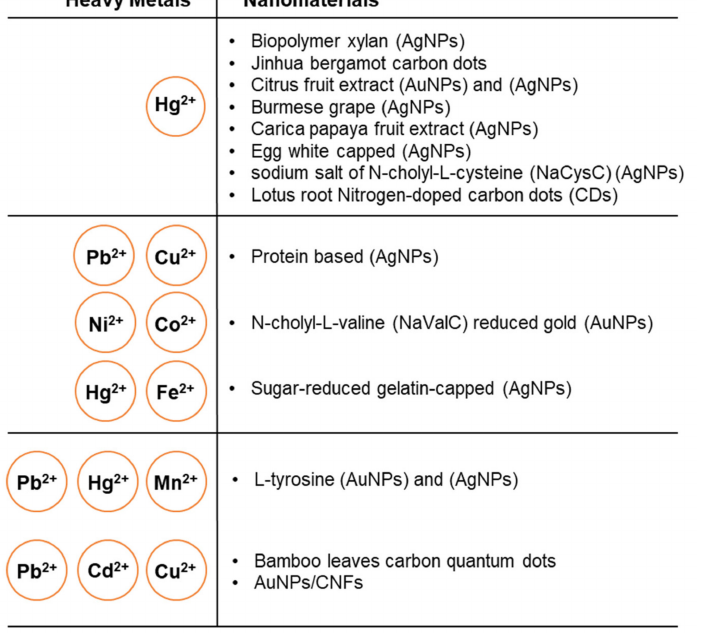
Figure 11. Nanomaterials used for detection of heavy metals (adapted from